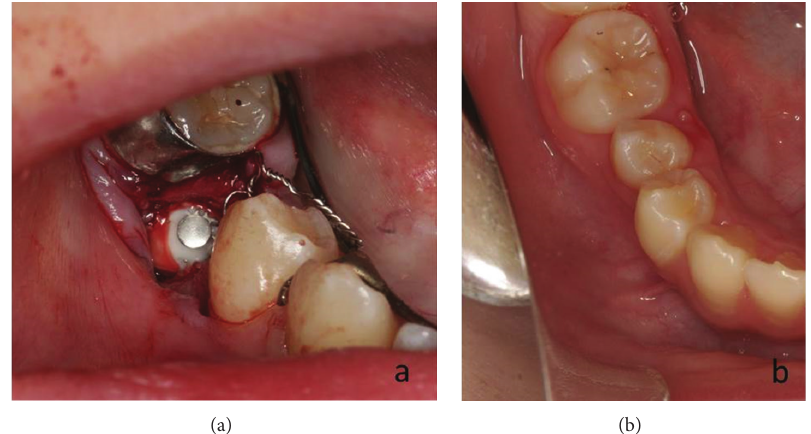
Figure 3: Intraoral photographs: case 1. (a) Fenestration was performed and traction applied to the permanent second premolar at age of 10 years and 2 months. (b) The permanent mandibular right second premolar has erupted into occlusion 14 months after traction at age of 11 years and 4 months.